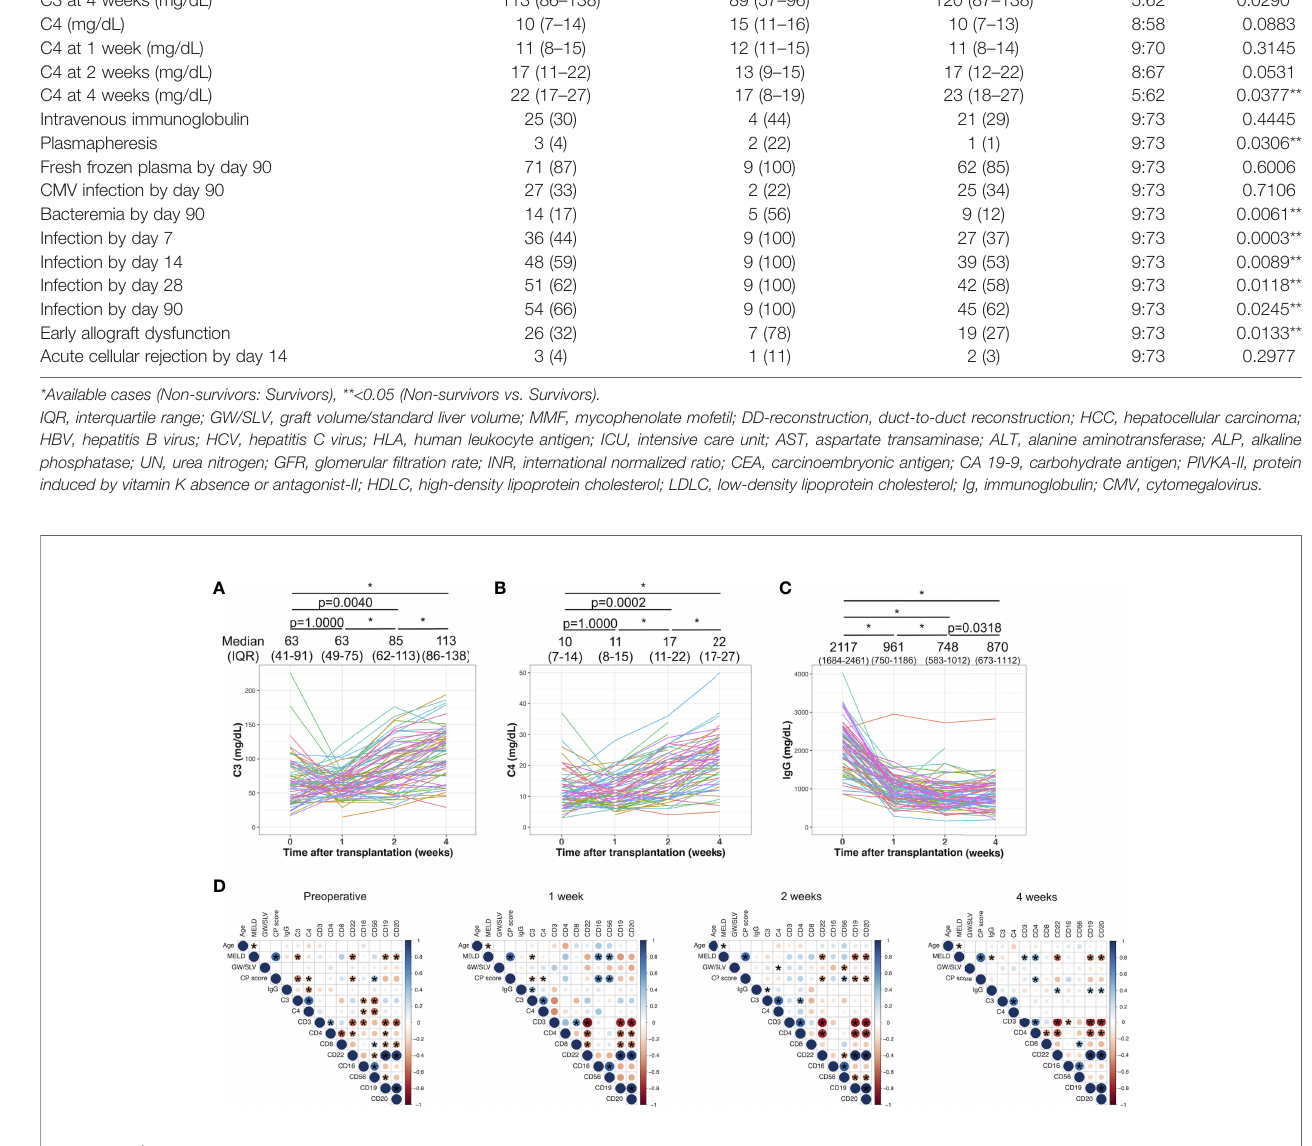
FIGURE 1 | The time-dependent changes in serum C3 (A) , C4 (B) , and IgG (C) . Changes among 4 time points were evaluated by the Wilcoxon signed-rank test with Bonferroni correction. *p value<0.0001. The median values and interquartile ranges are shown at each of the time points. (D) Correlations between clinical and laboratory variables at the preoperative examination, and at 1, 2, and 4 weeks after LDLT. Blue and red indicate positive and negative correlations between two variables, respectively. An asterisk denotes a p value of <0.05 between two